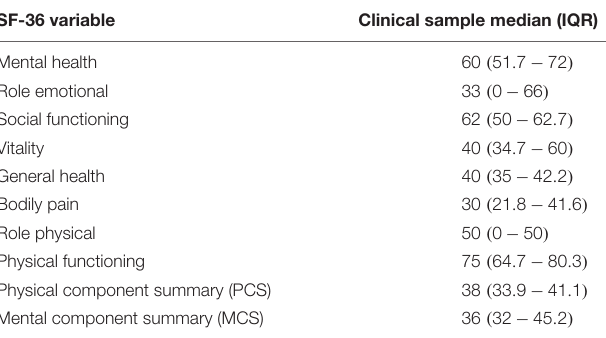
TABLE 2 | Measurements of health related quality of life (HRQoL) measured by the Short Form-36 (SF-36) questionnaire.